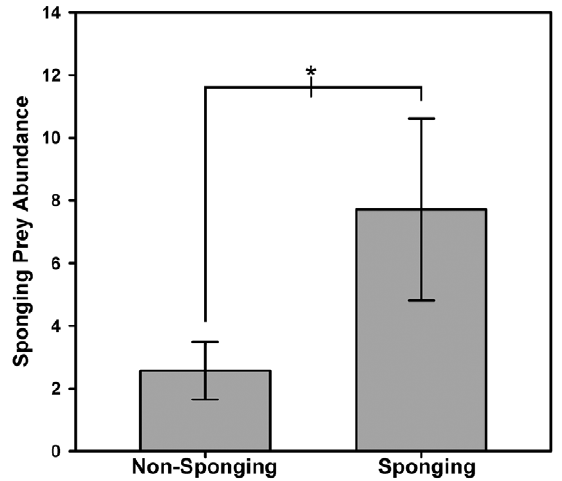
Figure 4. Abundance of prey species extracted during Sponging and abundance of these same families during Non-Sponging on transects. Wilcoxon sign-rank test W=28, *P=0.016.